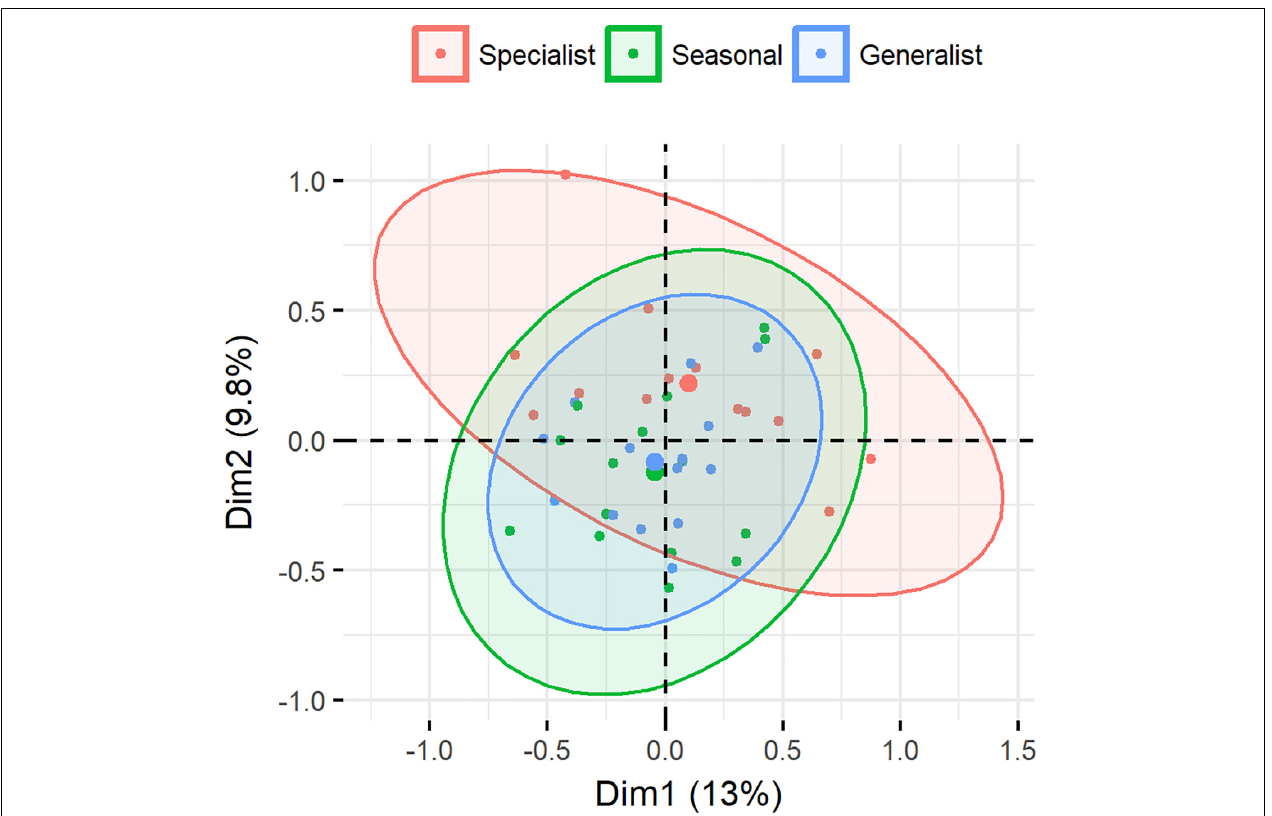
FIGURE 4 | Results of multiple correspondence analysis depicting the degree of similarity across responses to social-ecological propositions by livelihood